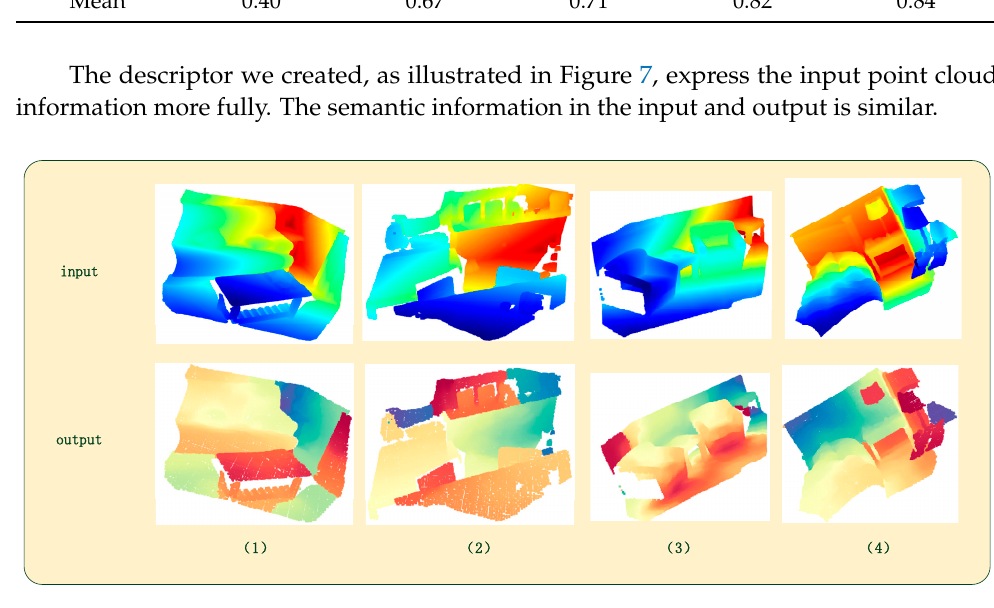
Figure 7. The visualization of 3DMatch dataset. The input is raw data. The output is descriptor after learning. ( 1 ) is point cloud sequence in group jan_1. ( 2 ) belongs to group redkitchen. ( 3 ) belongs to group studyroom2. ( 4 ) belongs to group scan3.